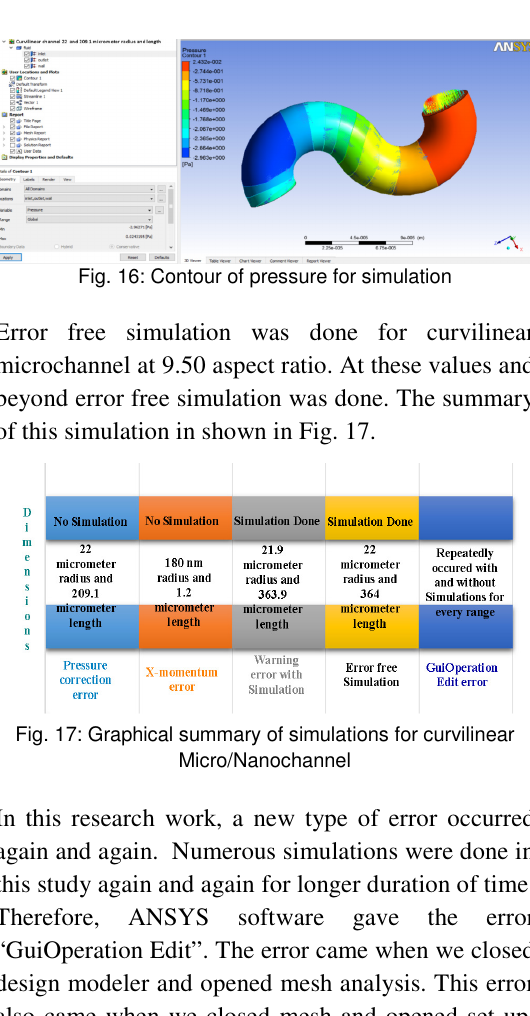
Fig. 17: Graphical summary of simulations for curvilinear Micro/Nanochannel